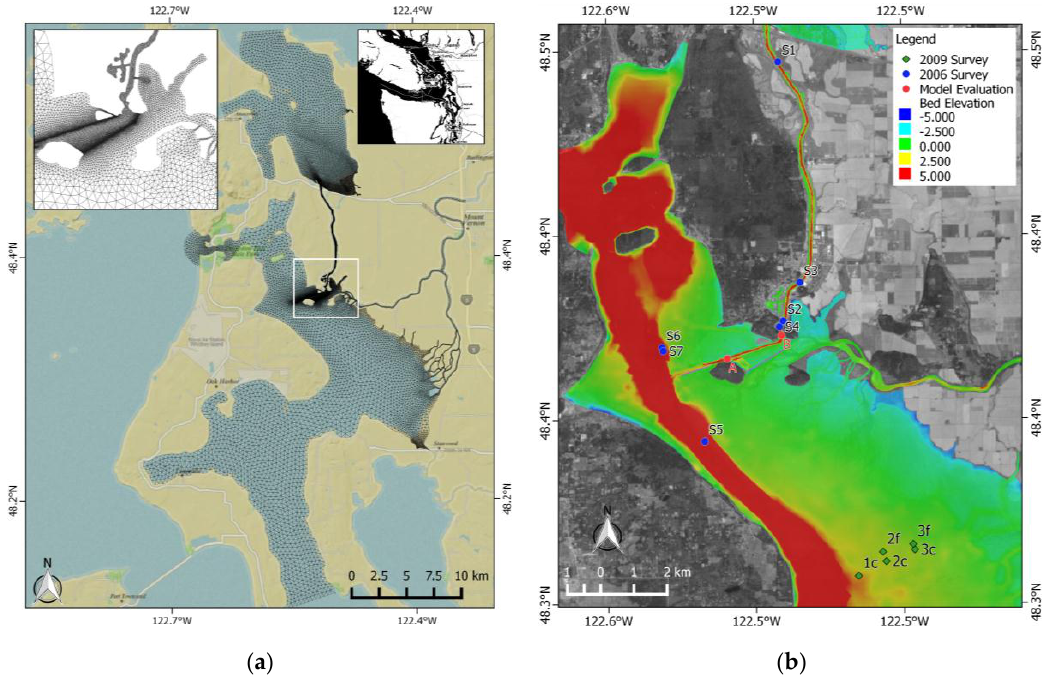
Figure 2. ( a ) The Skagit River estuary model grid with expanded domain covering Padilla Bay to the north and Saratoga Passage to the South with the Swinomish Channel connecting the two basins; ( b ) the locations of May 2006 (blue circles), WHOI study mooring stations during June of 2009 [13] (green diamonds), and for scenario evaluation (red circles).